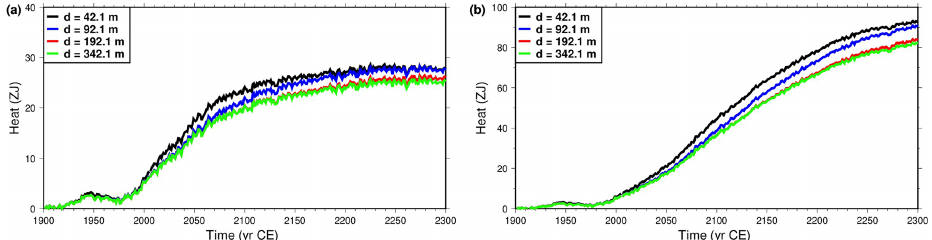
Figure 8. Heat stored in the upper 42.1m as function of time for models of subsurface thickness d of 42.1m (black), 92.1m (blue), 192.1m (red) and 342.1m (green). (a) Simulations forced with CRUNCEP + RCP4.5 data. (b) Simulations forced with CRUNCEP+RCP8.5 data. Note the vertical scale difference between the two